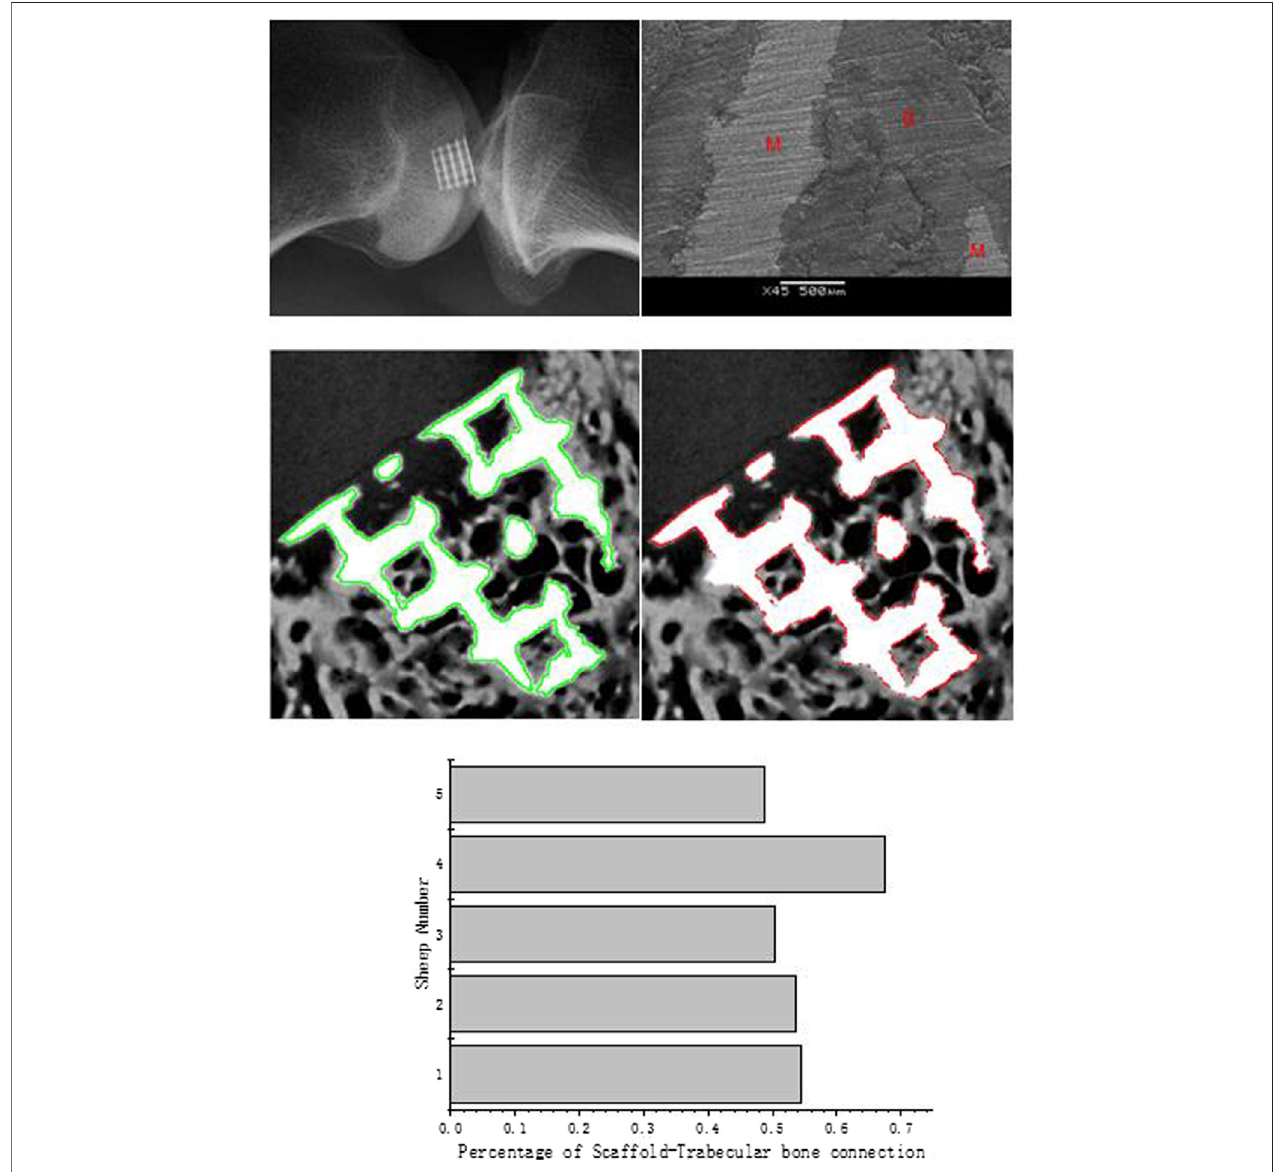
FIGURE7| X-raymicrographsofthescaffoldinthesheepcondyle (topleft) ;anSEMimageofscaffold – bonetissueconnection (topright; Mrepresentsthemetal alloy scaffold; B represents regenerated bone); the scaffold edge is identi fi ed by the green line (medium left) ; bone – scaffold connection is identi fi ed by the red line (medium right) ; percentage of scaffold – bone tissue connection (bottom)